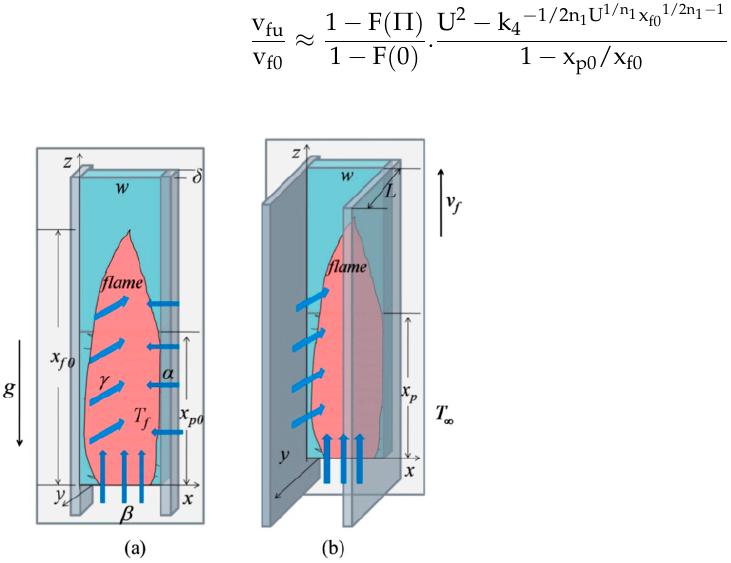
Figure 28. A physical representation of the ascending flame with a concave shape on PS ( a ) flat structures, ( b ) U-shaped structures [33]. structures, ( b ) U-shaped structures